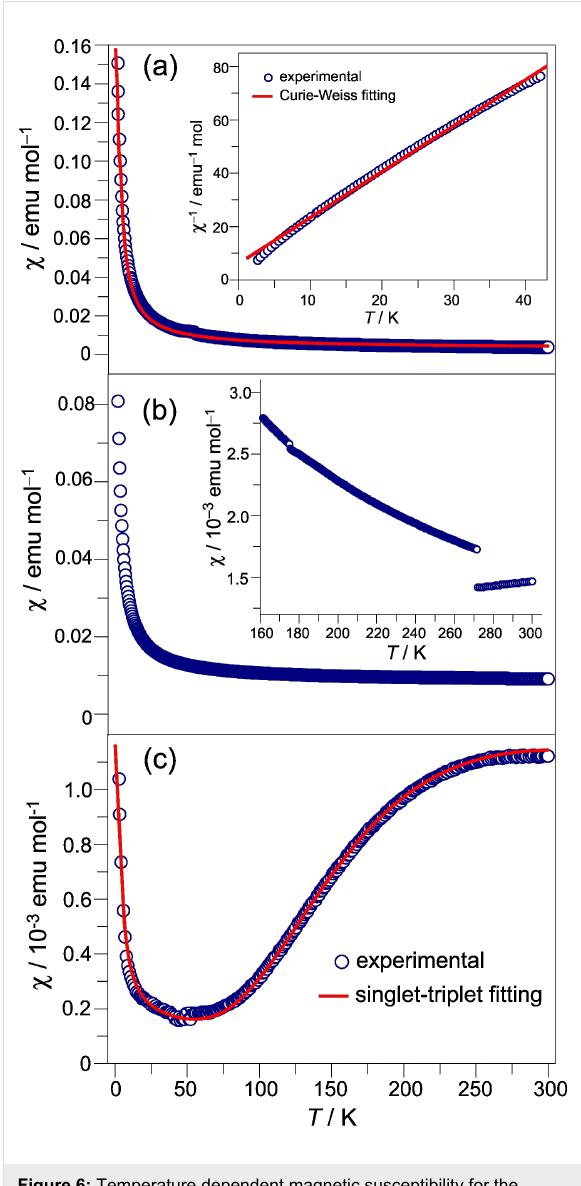
properties. The charge on TTFs in the salts depends on their second redox potentials ( E 1/2 2 ): E 1/2 2 > 0.90 V, radical cation; E 1/2 2 < 0.90 V, dication. Except compound 4 , which has the twisted central TTF core in the dicationic salt 4 ·CuBr 4 , the central TTF frameworks of these TTFs are nearly planar despite the charge on them. On the other hand, the anions in the salts show various configurations including the linear [Cu(I)Br 2 ] − ion, the tetrahedral [Cu(II)Br 4 ] 2 − ion, the planar [Cu(II) 2 Br 6 ] 2 − ion, the planar [Cu(II)Br 4 ] 2 − ion, and the distorted